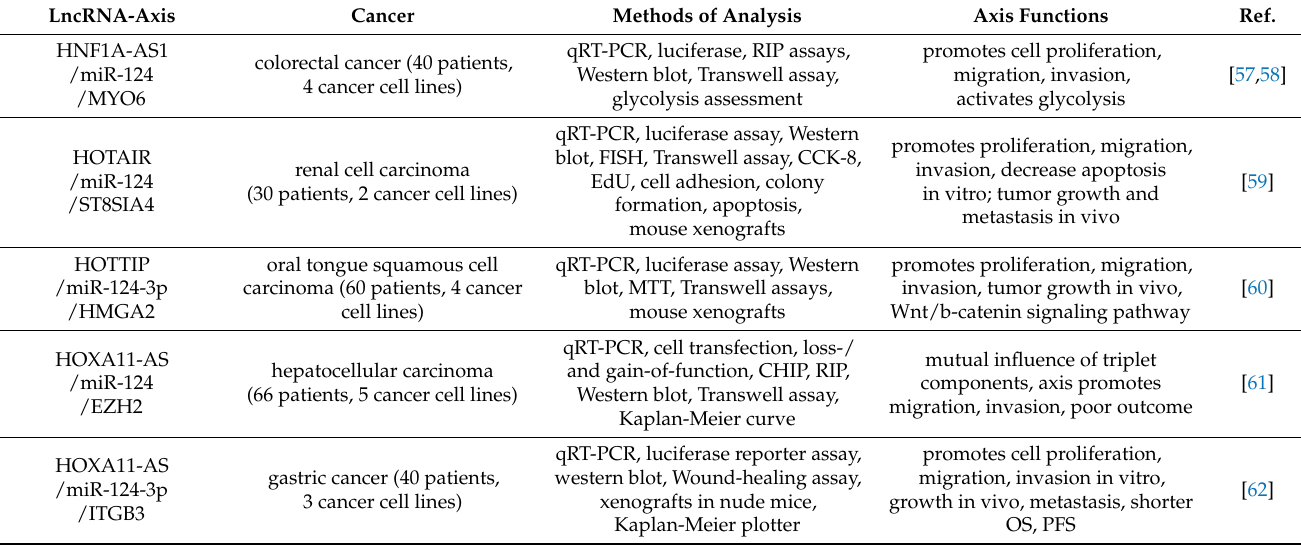
Table 1. Interactomes lncRNA/miR-124/mRNA-Target in Epithelial